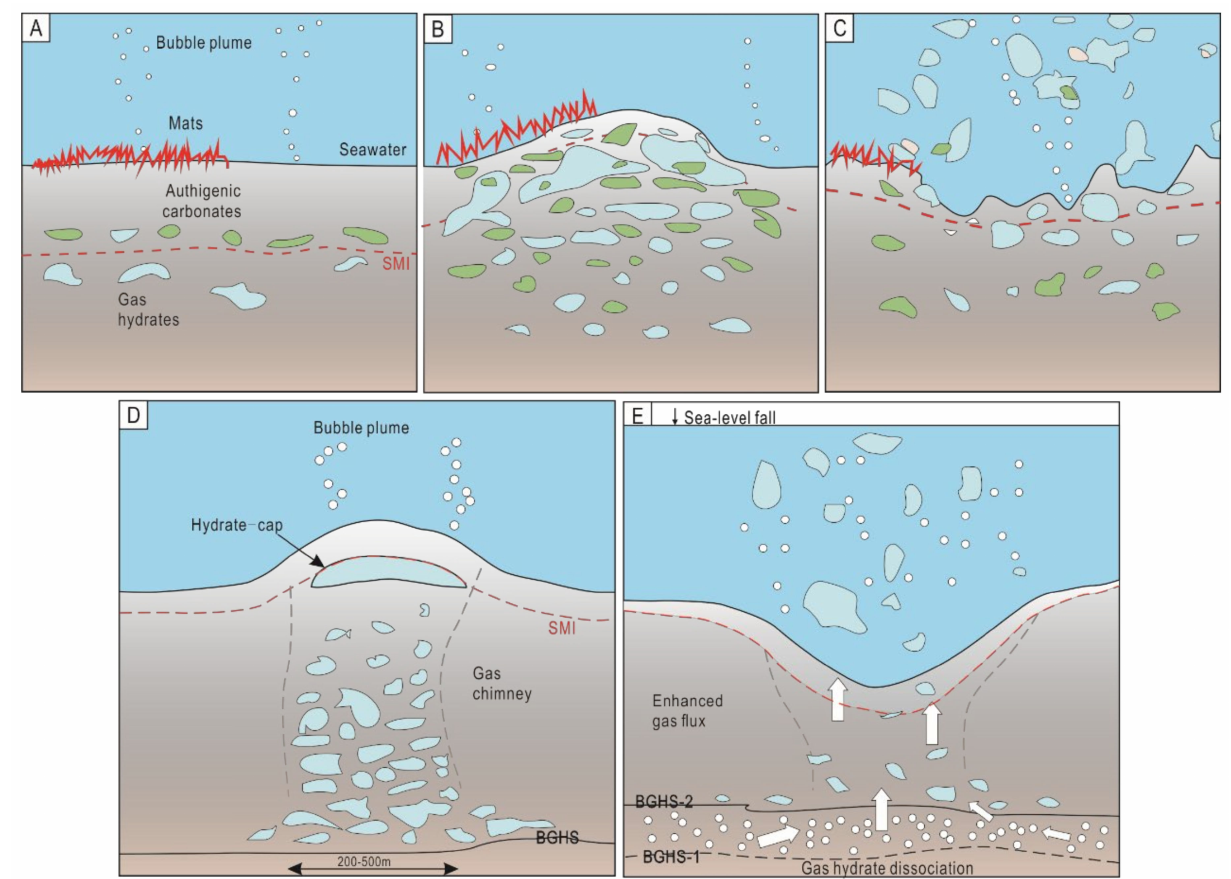
Figure 3. ( A – C ) Autocollapse model for the formation and collapse of shallow hydrate deposits. High hydrate concentrations on the seafloor would cause host sediment to swell and hydrates to float up. ( D , E ) As sea levels fell during the LGM, the chimney-controlled hydrate deposit at the depth of the BGHSZ dissociated, releasing large volumes of gas that migrated upward to the seafloor due to a lack of free water to reform hydrates in clay–silt host rocks. Hydrates loss resulted in large crater-like depressions and black–dark deposits ( E ) (modified from